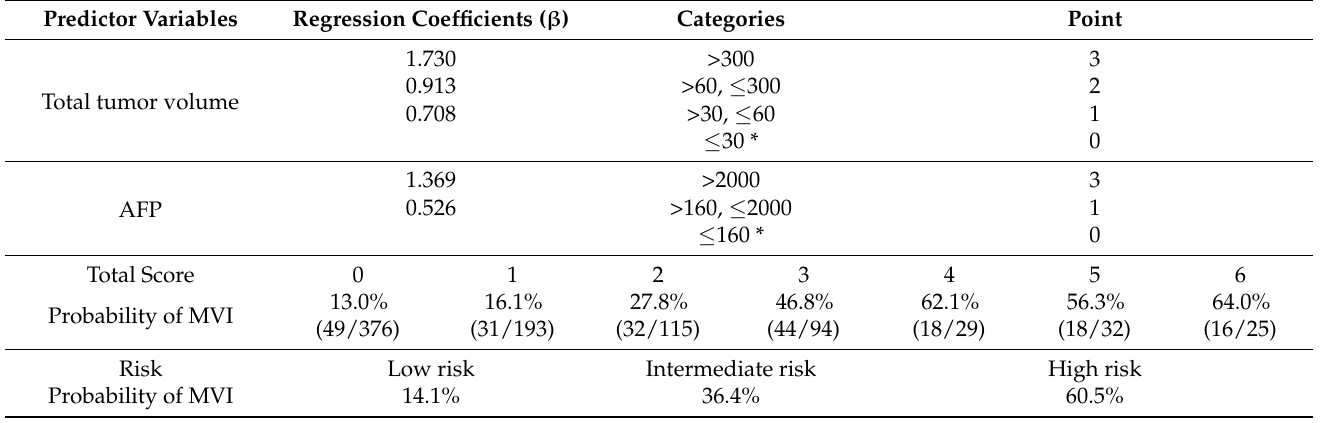
Table 3. Risk score model for the prediction of microvascular invasion.